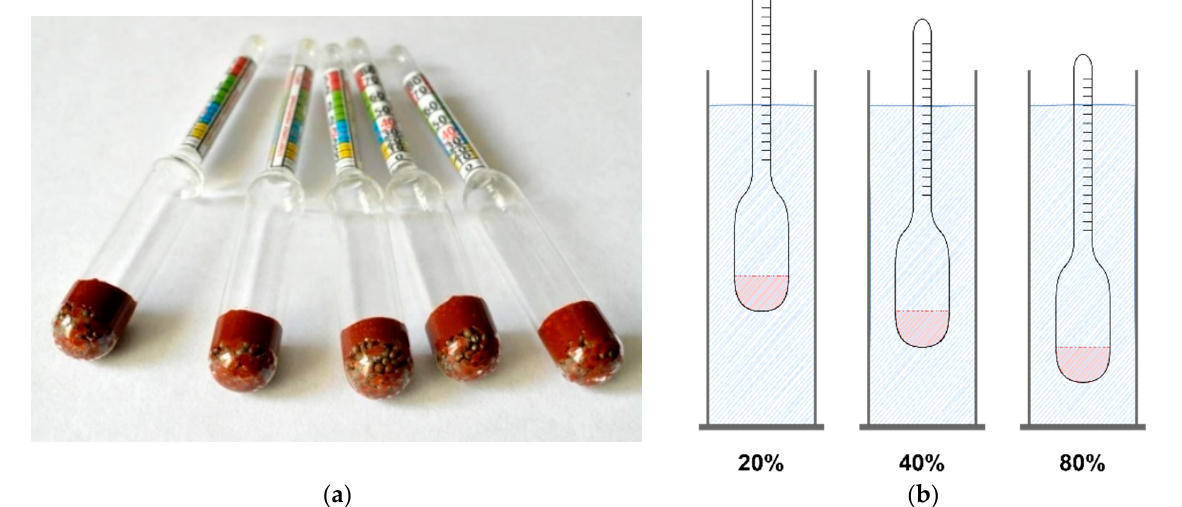
Figure 2. Traditional alcoholmeter illustration of: ( a ) various models with various measurement ranges; and ( b ) illustration of standard alcoholmeter measurement procedure and influence of alcohol concentration on alcoholmeter indication.